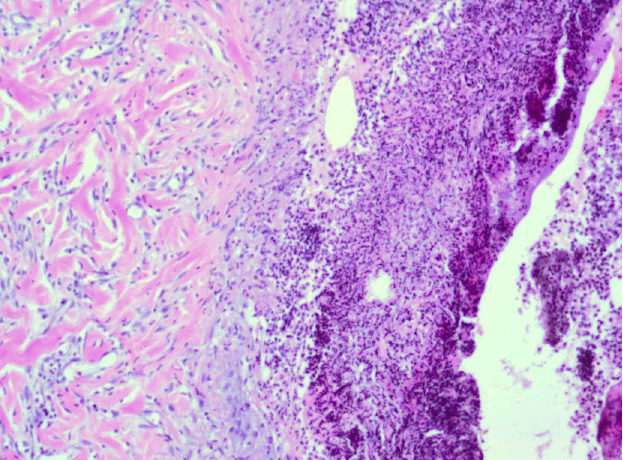
Figure 4. Day 7, D2-3% Sepropol, inflammatory exudate with great amount of granulocytes, on the bottom of the wound and at its edges granulation process marked (enlargement 150×,